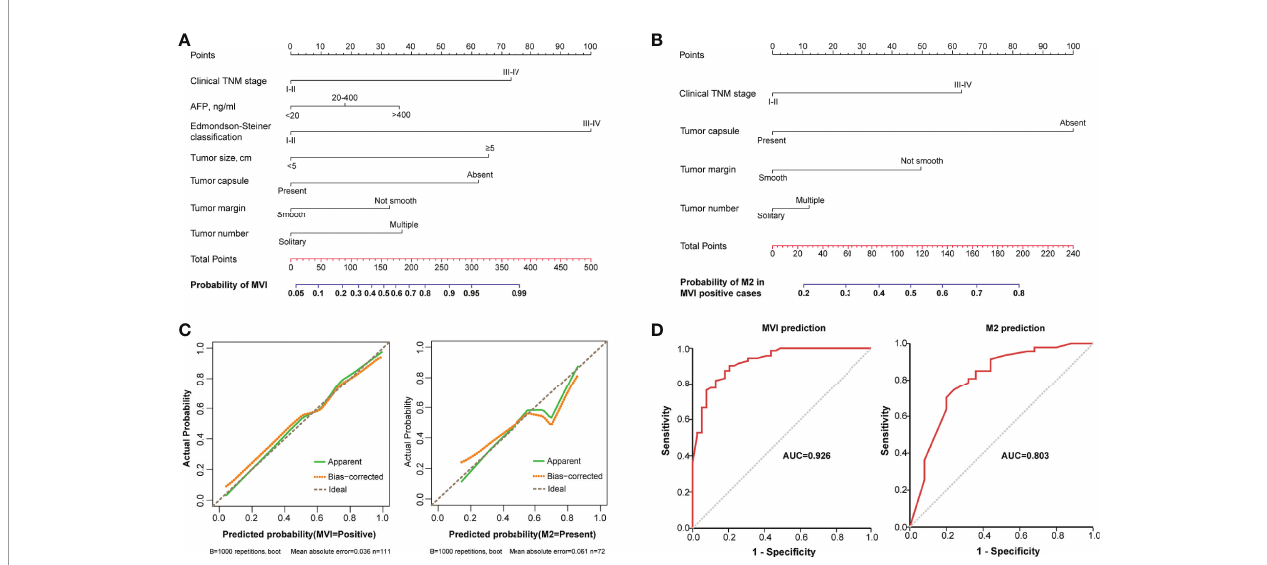
FIGURE 3 | The nomograms and their calibration and discrimination. (A) The MVI nomogram was built by incorporating clinical TNM stage, AFP, Edmondson – Steiner classi fi cation, tumor size, tumor capsule, tumor margin, and tumor number. (B) Among the MVI-positive cases, clinical TNM stage, tumor capsule, tumor margin, and tumor number were used to establish another nomogram for predicting M2 grade. Locate the patient ’ s characteristic on a variable row and draw a vertical line straight up to the points ’ row (top) to assign a point value for the variable. Adding up the total number of points and drop a vertical line from the total points ’ row to obtain the probability of predictive outcomes. (C) The calibration curves of the two nomograms based on internal validation with a bootstrap resampling frequency of 1,000. (D) The ROC curves with AUCs of 0.926 and 0.803 to demonstrate the discriminatory ability of the two